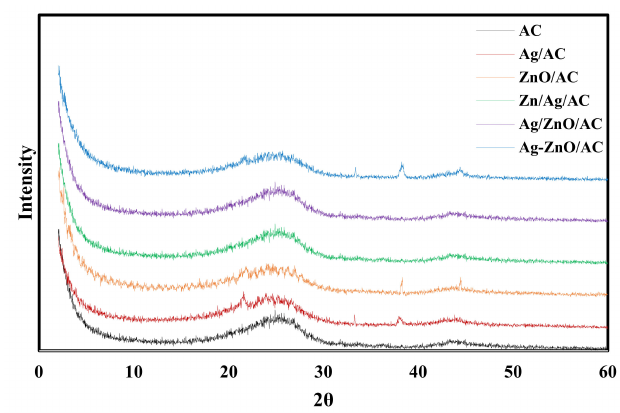
Figure 5. X-ray di ff raction of AC, Ag / AC, ZnO / AC, Ag / ZnO / AC, ZnO / Ag / AC, and Ag-ZnO / AC.